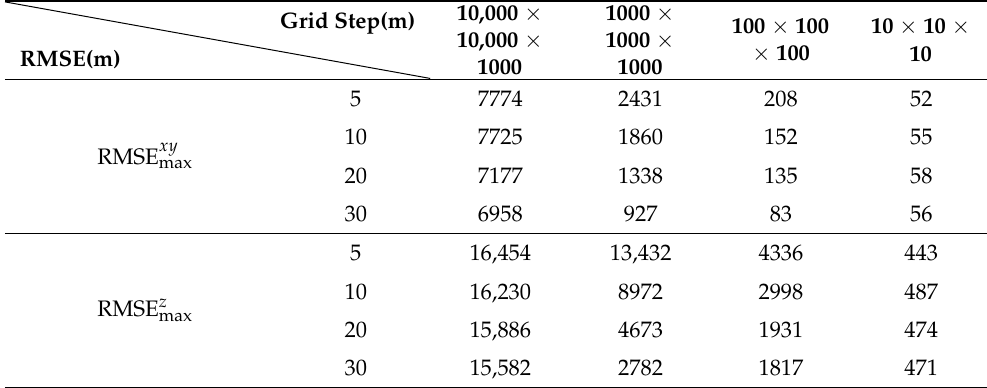
Table 2. Maximum RMSE under different grid step and number of receivers outside the receiver